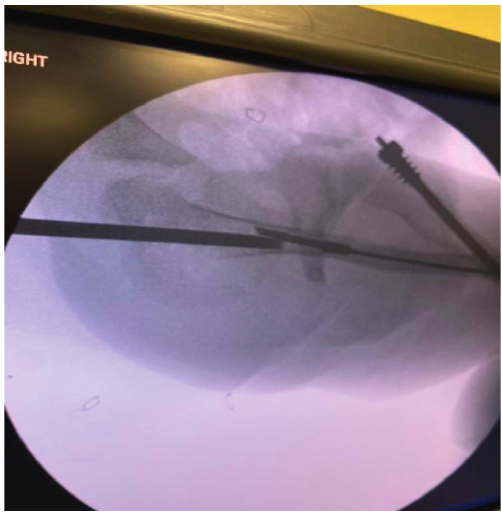
Figure 2: Lateral of the right femur demonstrating the fractured portion of the male retrieval shaft attached to the male